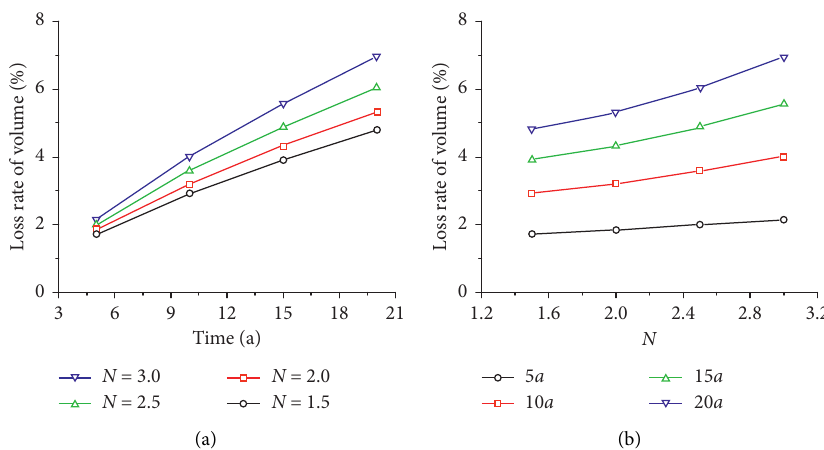
Figure 9: Variation of volume loss rate of single-cavern horizontal salt rock underground storage with operation time and diameter-to- height ratio. (a) The variation of volume loss rate with operation time. (b) The variation of volume loss rate with diameter-to-height